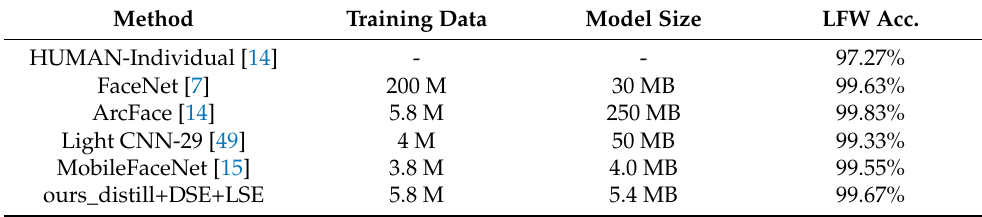
Table 7. Performance comparison with SOTA